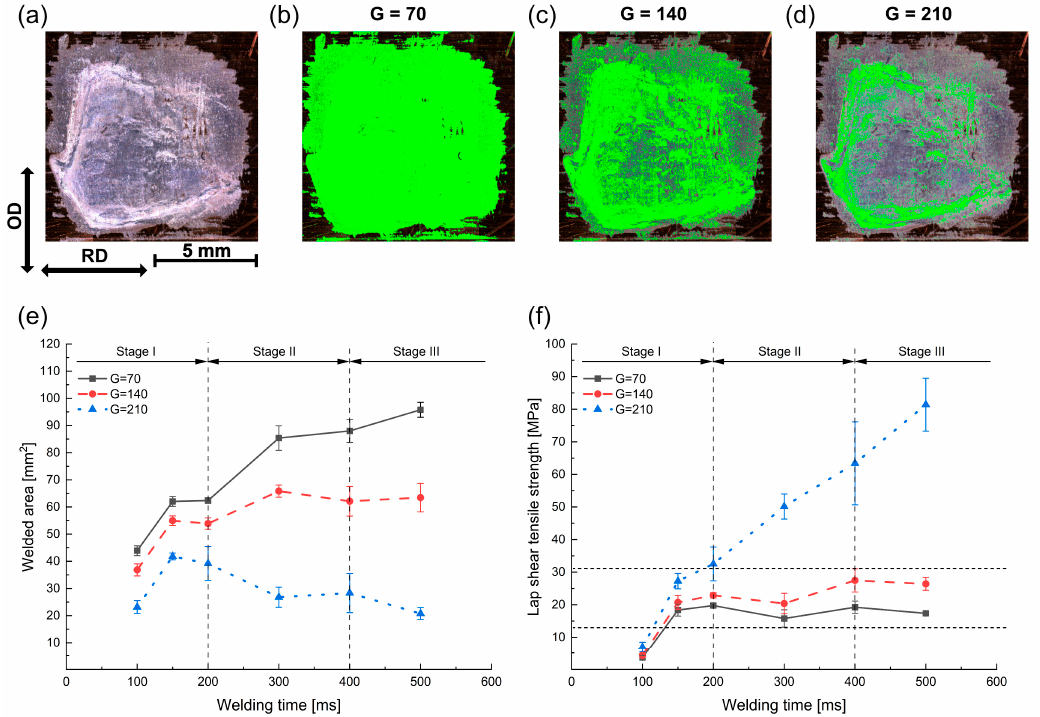
Figure 12. ( a ) Fracture surface of Al/Cu joints at 500 ms: the welded area as measured from the image processing technique ( b ) G = 70, ( c ) G = 140, and ( d ) G = 210. Variation in ( e ) welded area and ( f ) lap shear tensile strength with welding time.